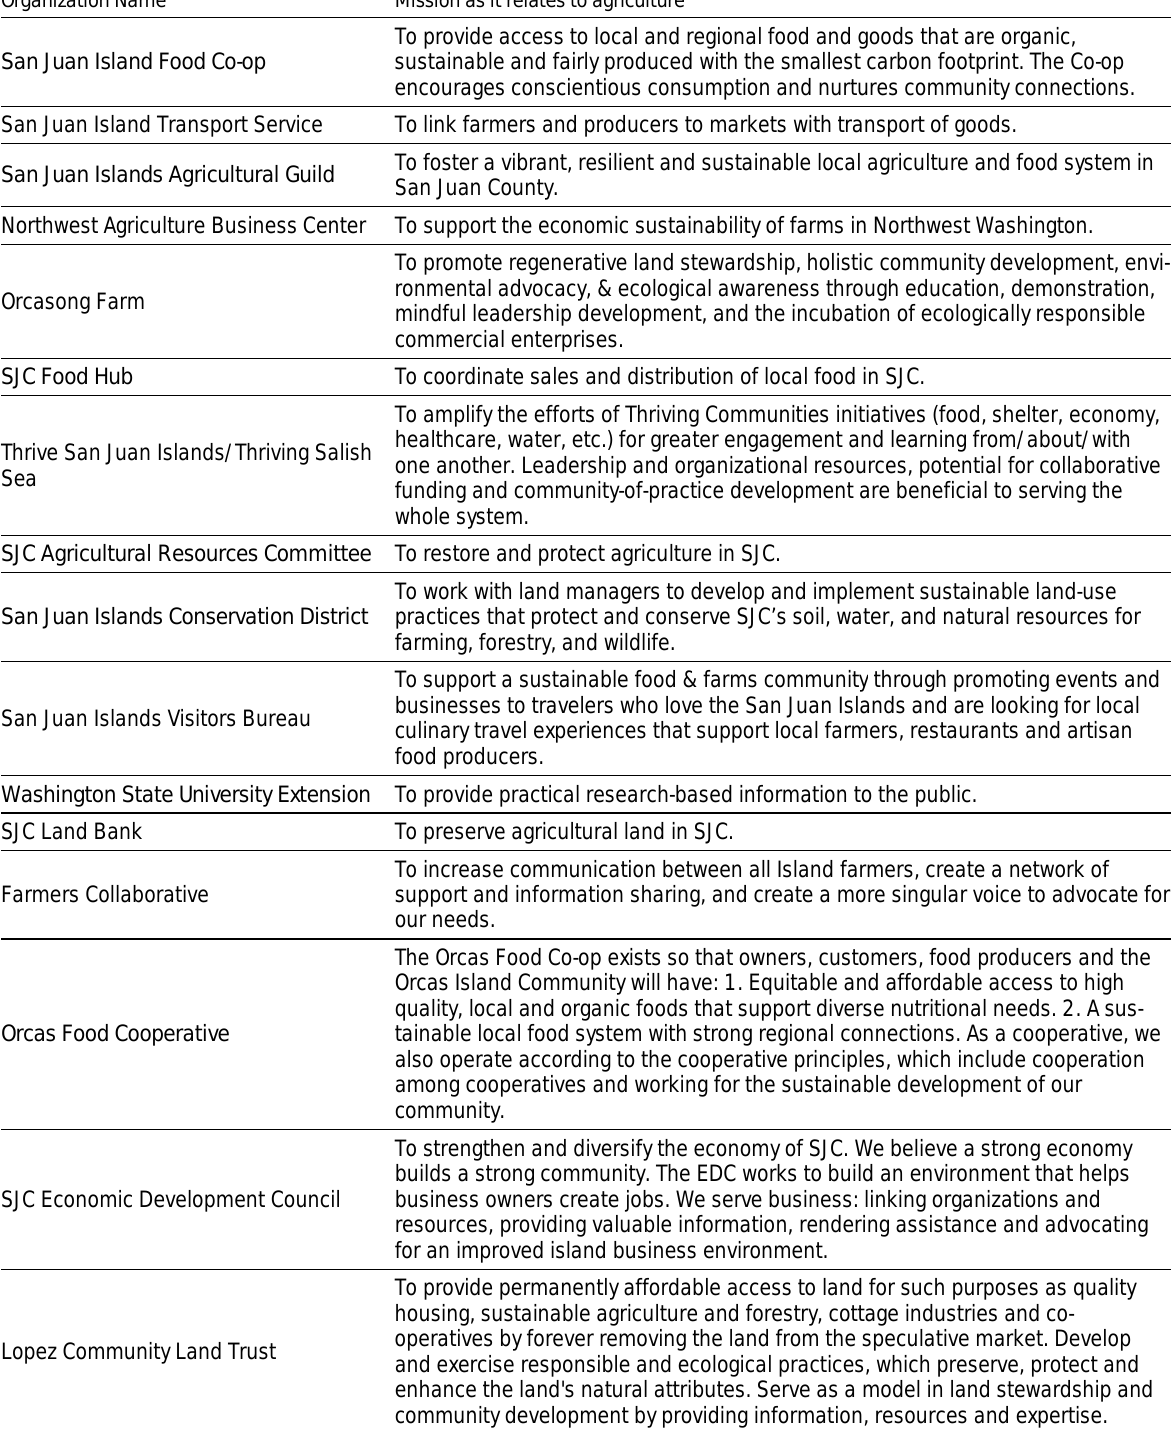
Table 1. Participants in the 2016 SJC Agricultural Organizations Annual